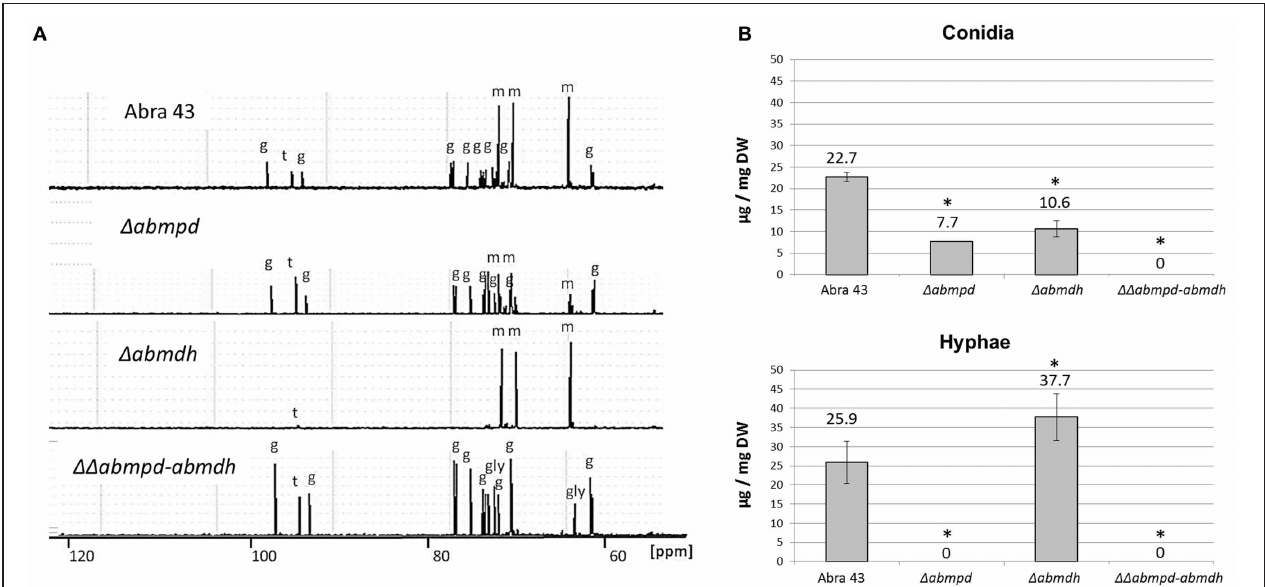
representative spectra are presented here. (B) Mannitol content [expressed in μ g/mg DF (dry weight)] obtained by HPLC analysis of extracts from mature conidia and young non-sporulating mycelium. Mannitol was extracted from at least three independent biological replicates. Error bars indicate standard deviations. Asterisks indicate a significant difference between the mutant and the parental isolate (Student test, P < 0 .